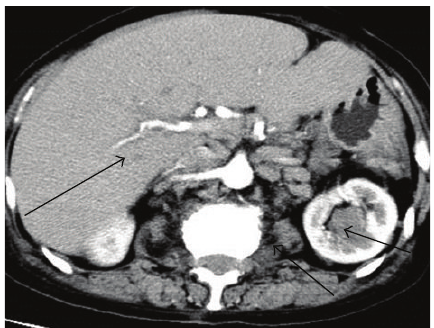
Figure1:CTresultsuggestsmultipleroundmassesintheparaspinal and thoracic regions and bilateral pleural effusions. On November 13, 2009, CT scan was performed, and the left arrow indicated pleural effusion, and the right arrow suggested rounded soft mass surrounding vertebrae.